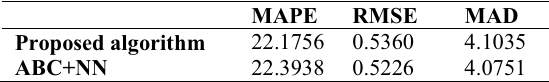
Table 11. Comparative analysis of proposed rainfall